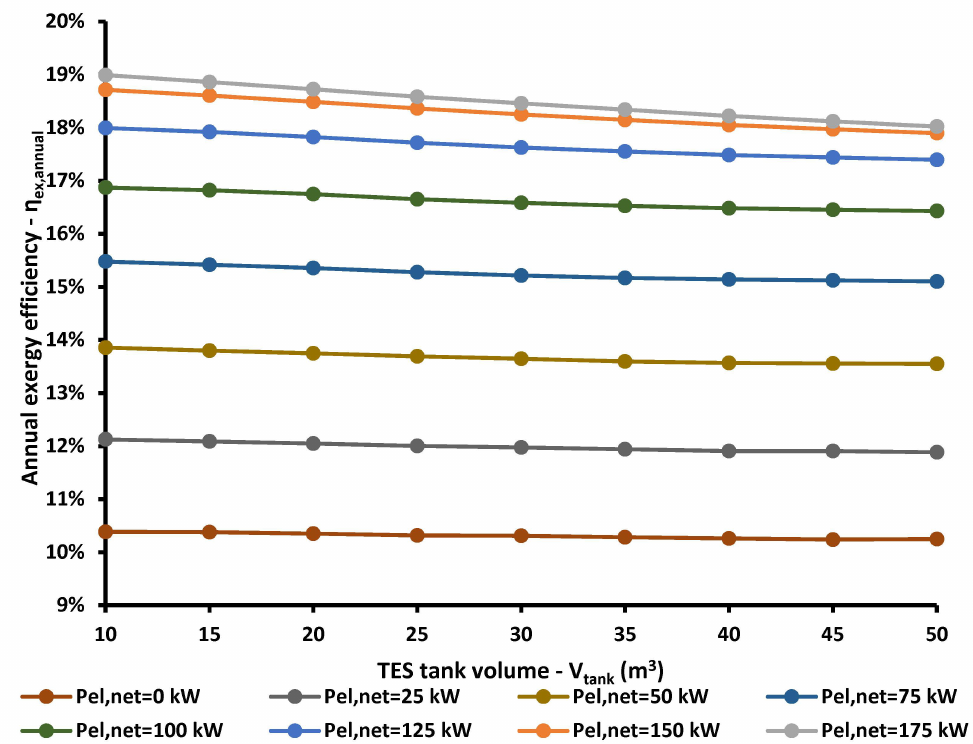
Figure 8. Annual exergy efficiency for different values of net electricity load and TES tank